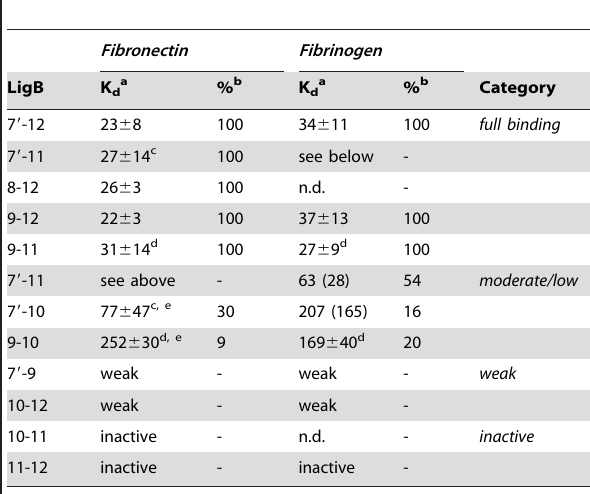
Table 2. Relative affinities of LigB proteins for fibronectin and